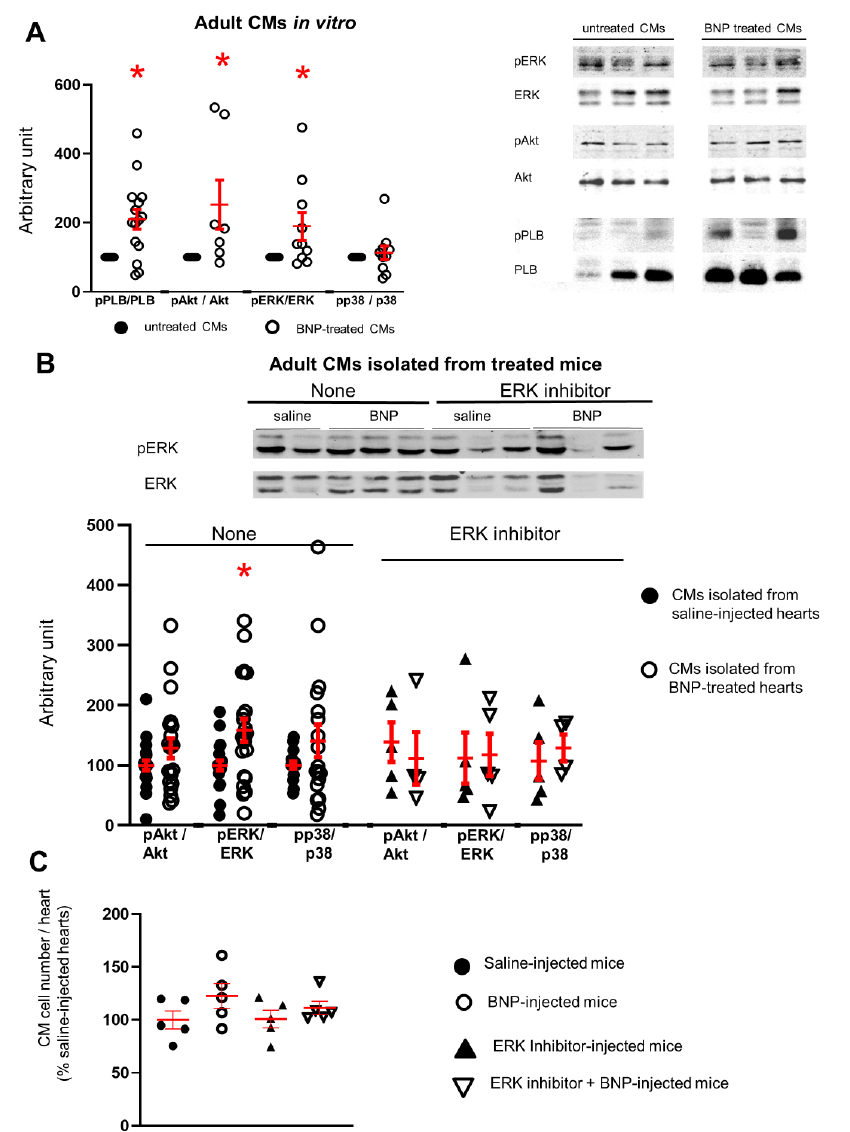
Figure 6. The ERK MAP kinase signaling pathway is activated in cardiomyocytes after BNP treatment in vitro and in vivo. ( A , B ) Measurement of phospho phospholamban (pPLB)/phospholamban (PLB), pAkt/Akt, pERK/ERK and pp38/p38 ratio by Western blot analysis in adult CMs stimulated or not with BNP for 1-6h in vitro ( A ), (n = 7–14 different CM isolations) or in CMs isolated from unmanipulated adult hearts injected with saline or BNP for 2 weeks ( B ) left , (n = 20 saline and 21 BNP-injected hearts). ( B ), right : CMs were also isolated from adult unmanipulated hearts treated with ERK inhibitor (PD0325901) 1h before saline or BNP injections. n = 5 different mice per group. Total protein stainings used as loading control (Supplementary Figure S5) and quantification of all the results obtained related to the average of untreated CMs (black circle for A ) or of CMs isolated from saline-injected hearts ( B ), (black circles). ( C ) Number of CMs isolated from adult unmanipulated hearts treated or not with ERK inhibitor before BNP or saline injections. Mice (n = 5 per group) sacrificed after 2 weeks of BNP treatment. The number of CMs in BNP-treated hearts related to the numbers found in saline-injected hearts. Individual values represented and the means ± SEM depicted in red. * p < 0.05 versus untreated CMs or CMs isolated from saline-treated